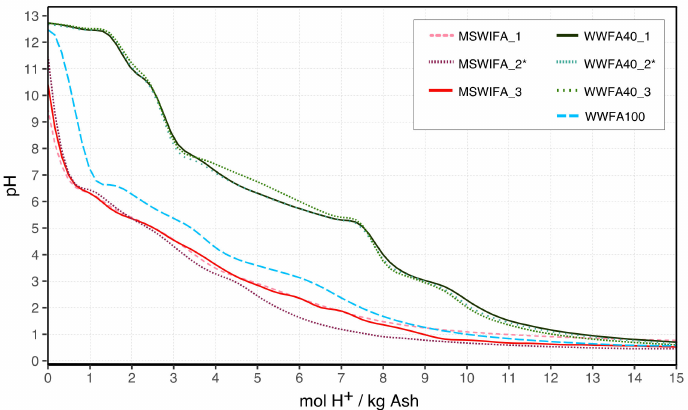
Figure 1. Titration curves of acid-neutralizing capacity (ANC) for MSWIFA, WWFA40 and WWFA100. The samples used for the leaching experiments are indicated with *.